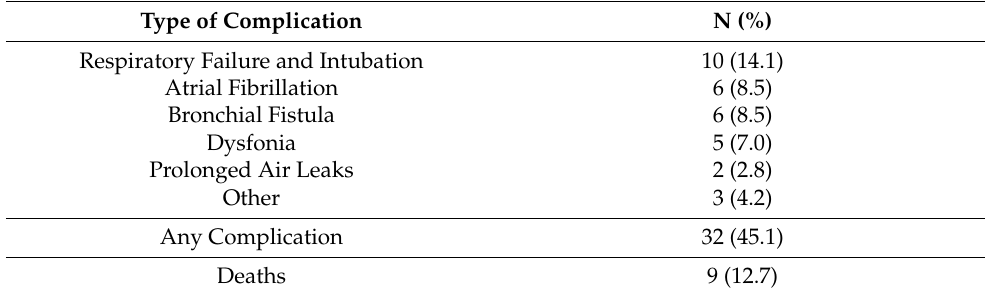
Table 4. Complications and deaths after reoperation distribution frequency, N = 71.